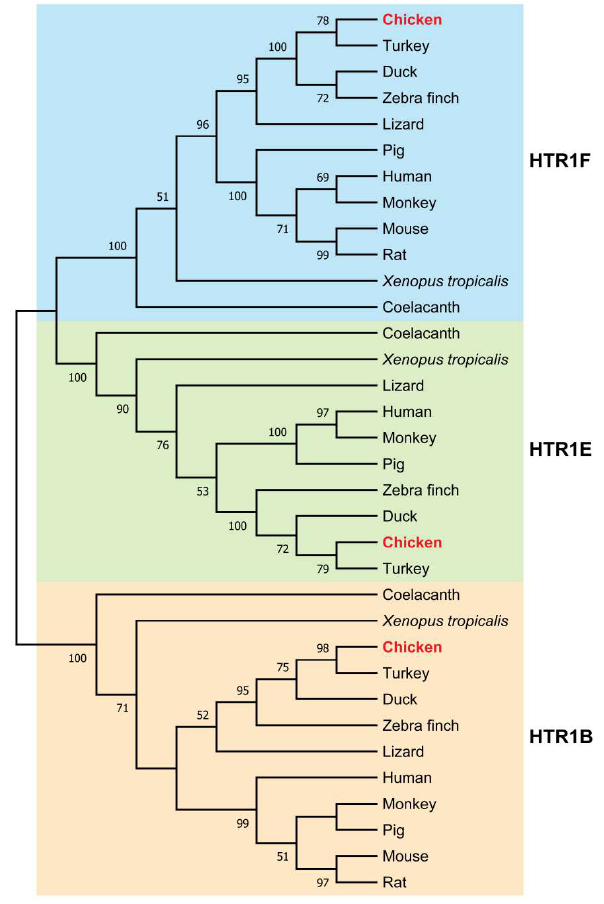
Figure 2. The phylogenetic tree of HTR1B , HTR1E , and HTR1F . Based on 1000 bootstrap replicates, the neighbor-joining method was used to construct the phylogenetic tree. The bootstrap value is indicated near the branch